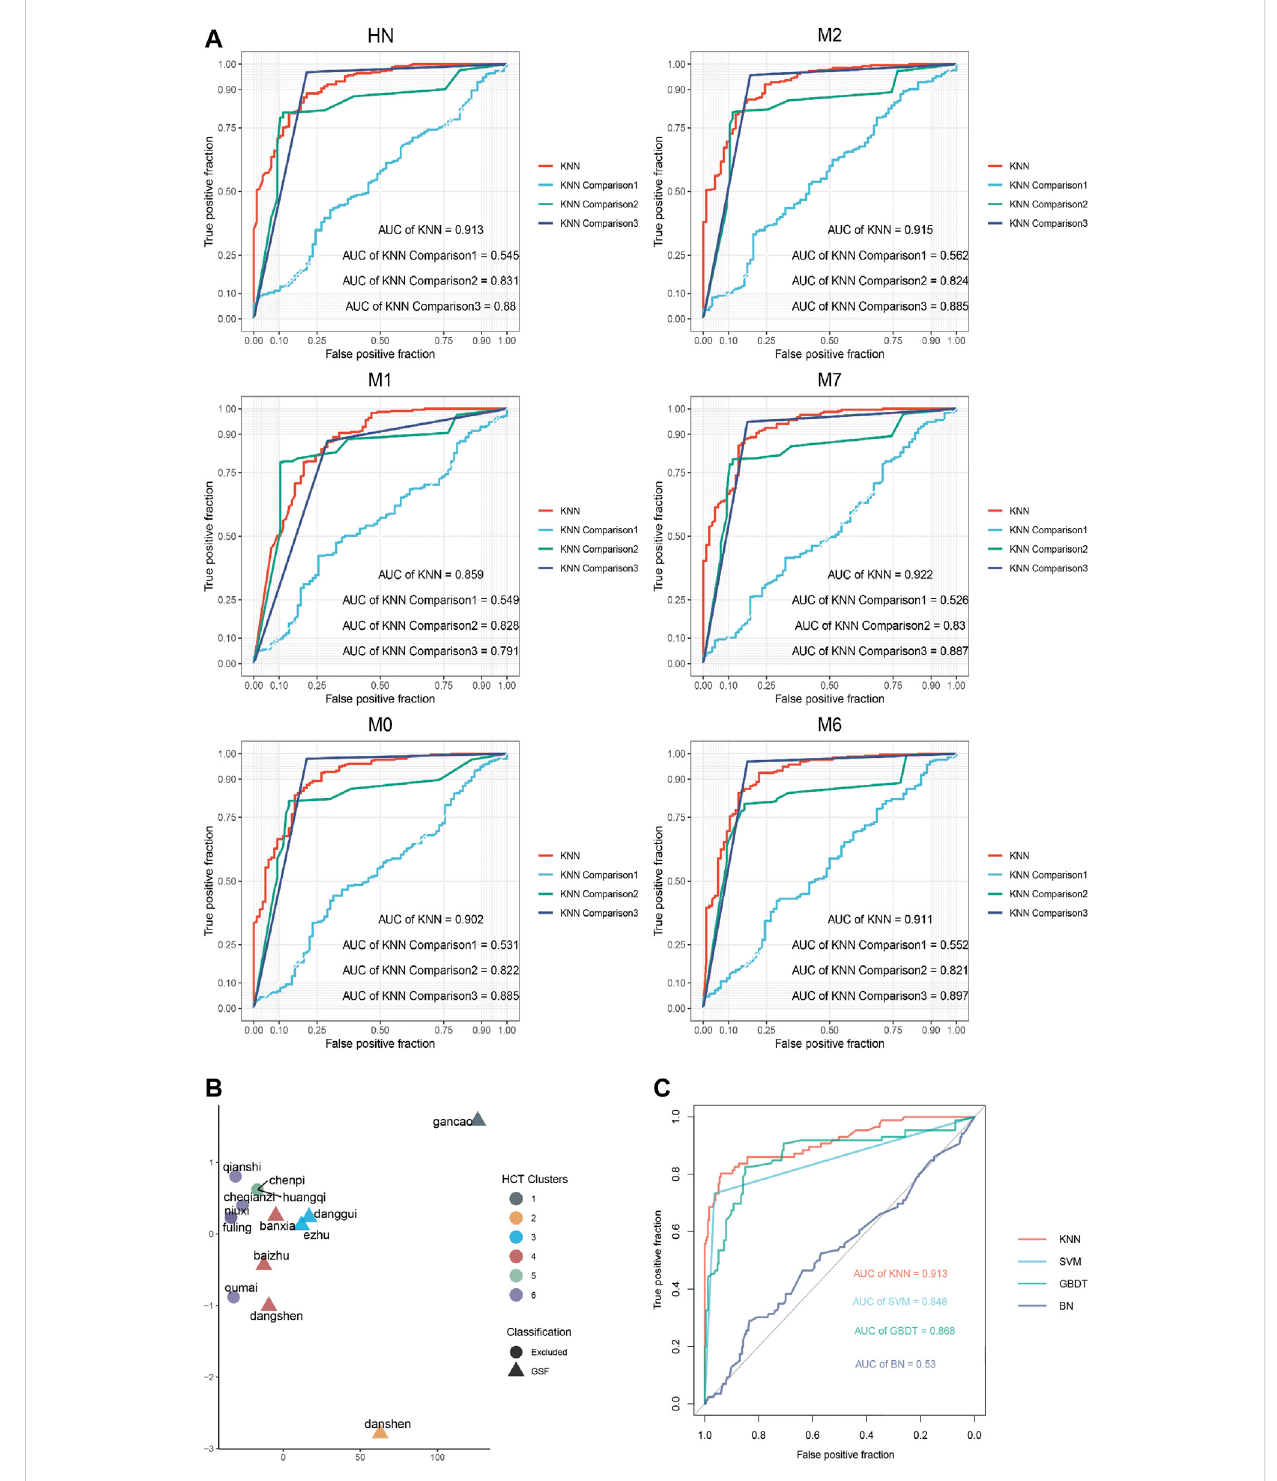
FIGURE 3 Resultsobtainedusingthemachinelearningmodel. (A) ROCcurvesobtainedusingtheKNNmodel. (B) Hierarchicalclusteringofbotanicaldrugs. (C) ROC curves obtained using each comparison